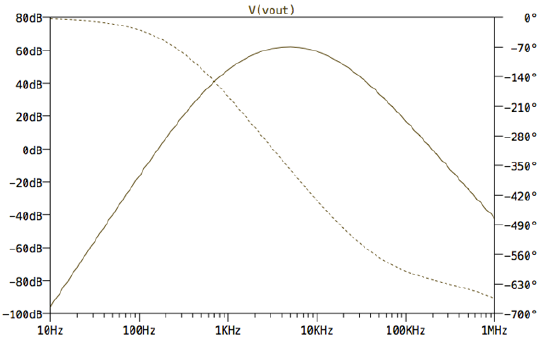
Figure 4. Response of the FMCW Radar Filter – magnitude (solid), phase (dotted)